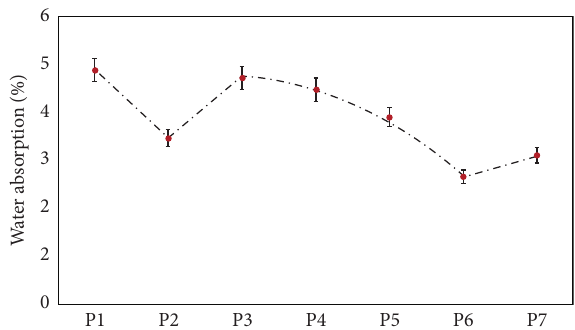
Figure 13: Water absorption test results of the composite